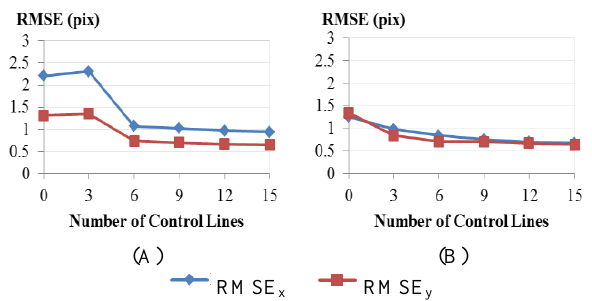
Figure 8. Results of line control with (A) 3 GCPs (B) 6